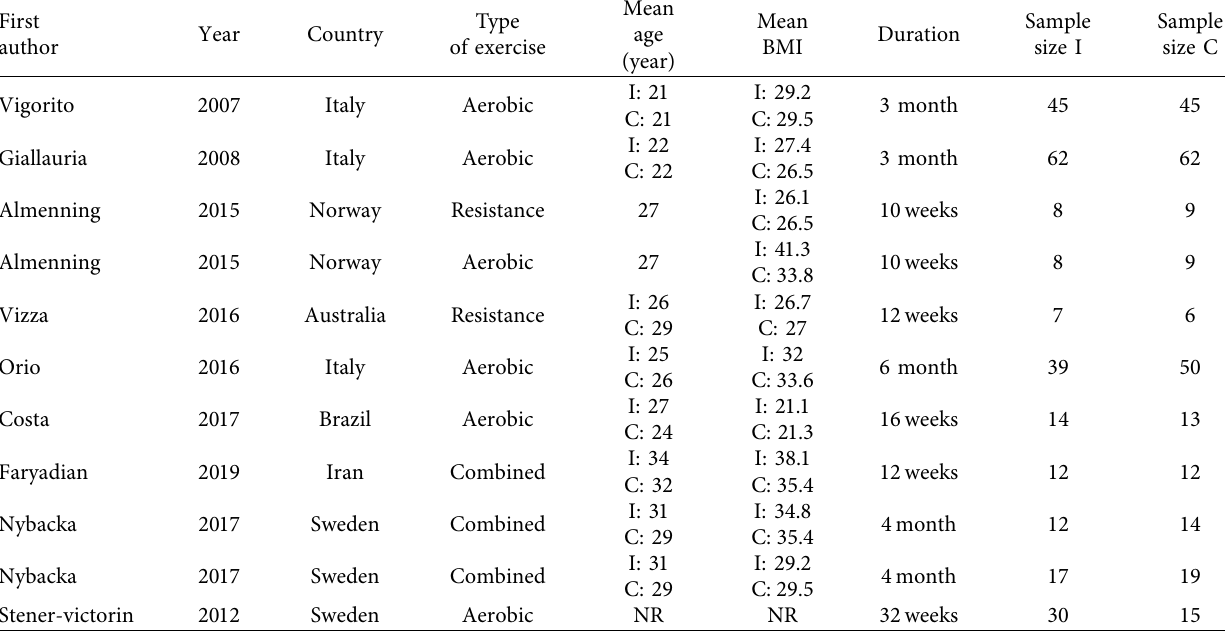
Table 1: Characteristics of studies included in this systematic